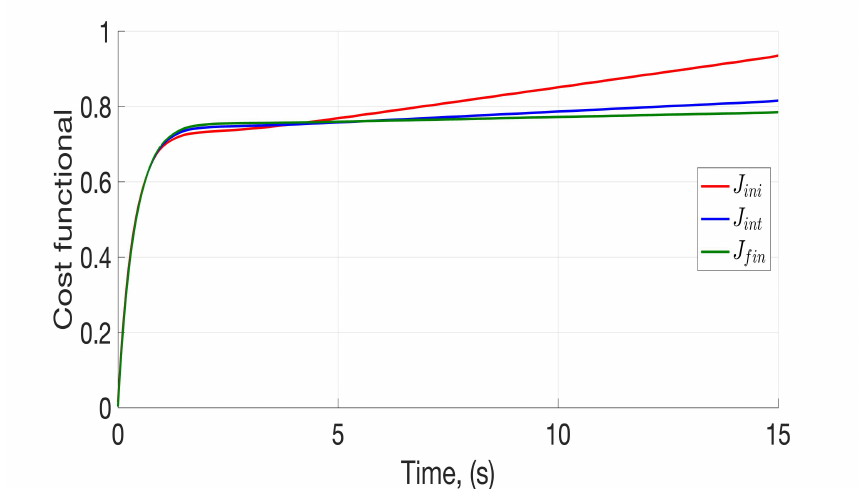
Figure 8. Temporal behaviour of the cost function depending on the sequence of stages evaluated over the sequence of